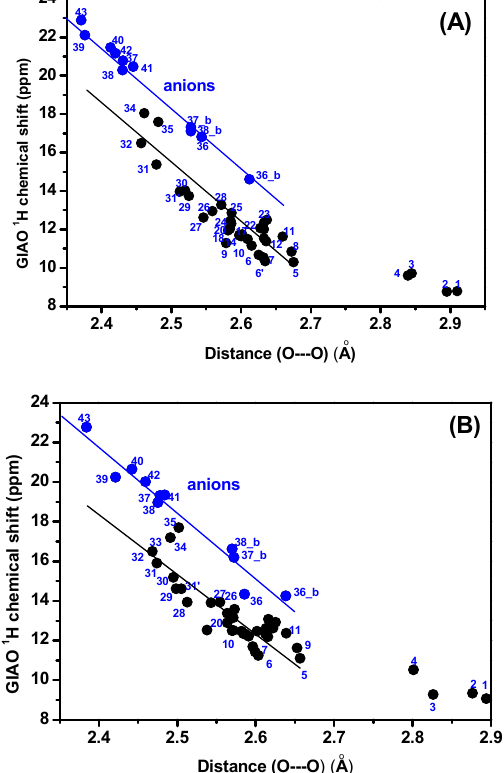
Figure 12. Calculated 1 H chemical shifts [at the GIAO DFT/B3LYP/6-311+G(2d,p) level of theory with CPCM (CHCl 3 )] vs. O ··· O distances of the compounds of Figure 9 with minimization of the structures at the M06-2X/6-31+G(d) ( A ) and B3LYP/6-31+G(d) ( B ) level of theory. The notation b refers to the bent complex (see text and Table 1). Reprinted, with permission, from [47]. Copyright 2015, The Royal Society of Chemistry.